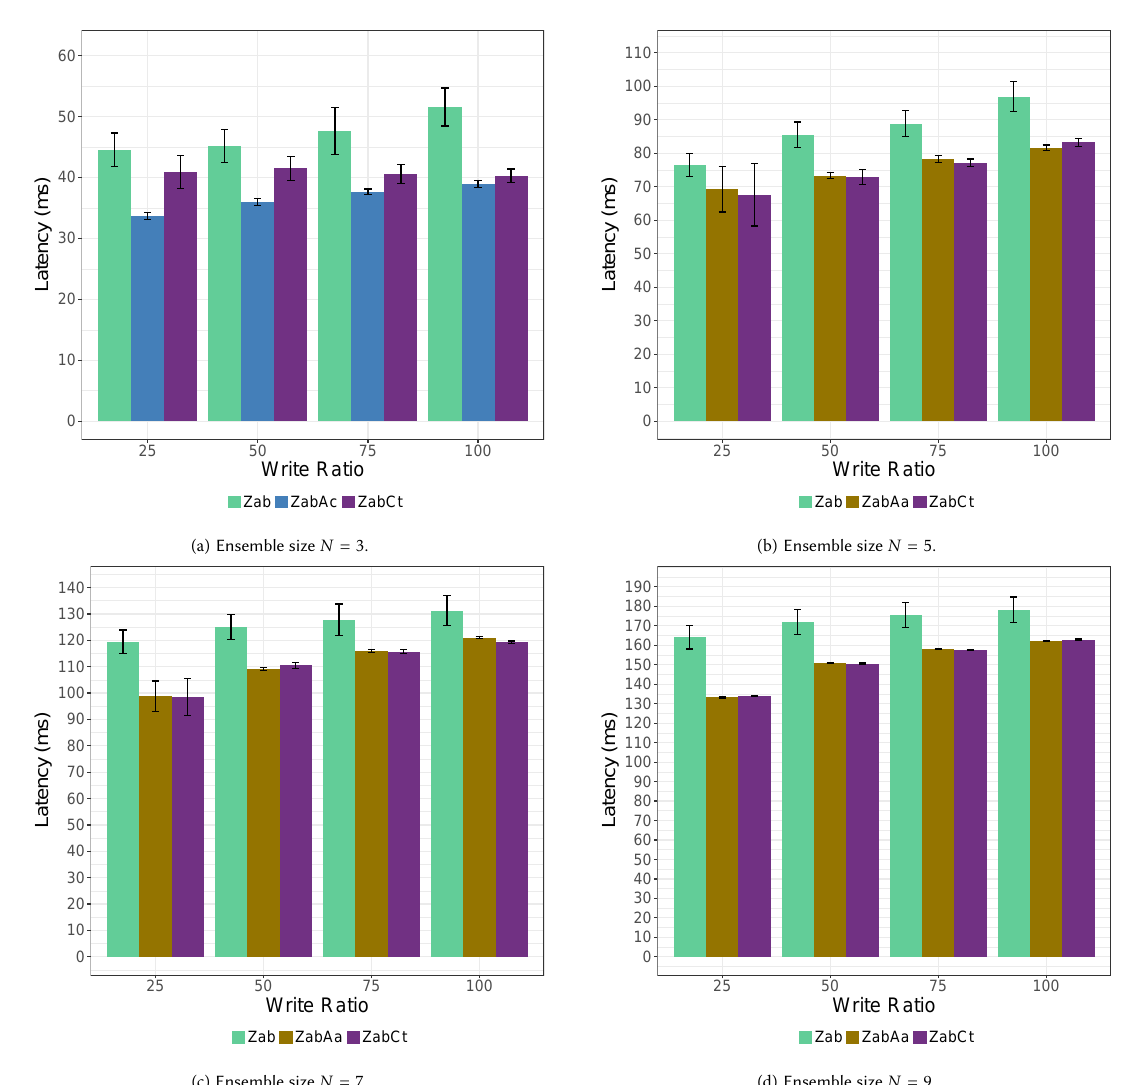
Figur e 2. Latency